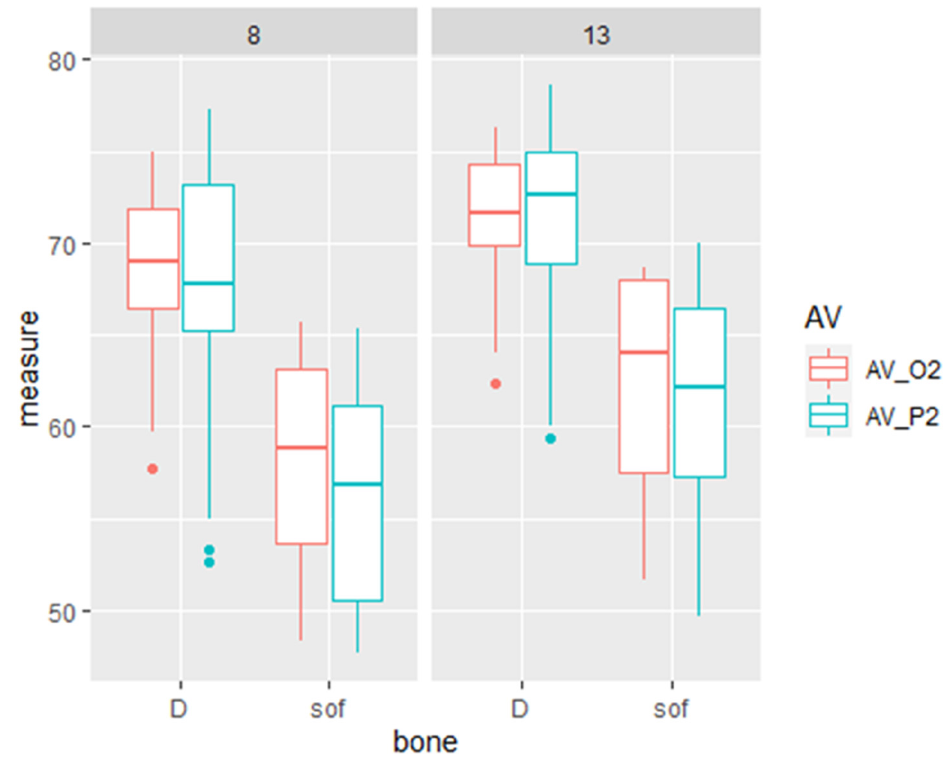
Figure 4. The effect of implant length and bone type on implant stability. Box and whiskers plot of the RFA measurements of Osstell (O2) and Penguin (P2) in the D = dense and sof = soft bone type, in different implant length 8 or 13 mm. The box represents the interquartile range and the median, and the whiskers represent the SD. There are some values that are outliers. Table 3. The difference of average implant stability measurements between the combined tested parameters of bone type and implant length as measured by the IT, Osstell (O2), and Penguin (P2) devices.